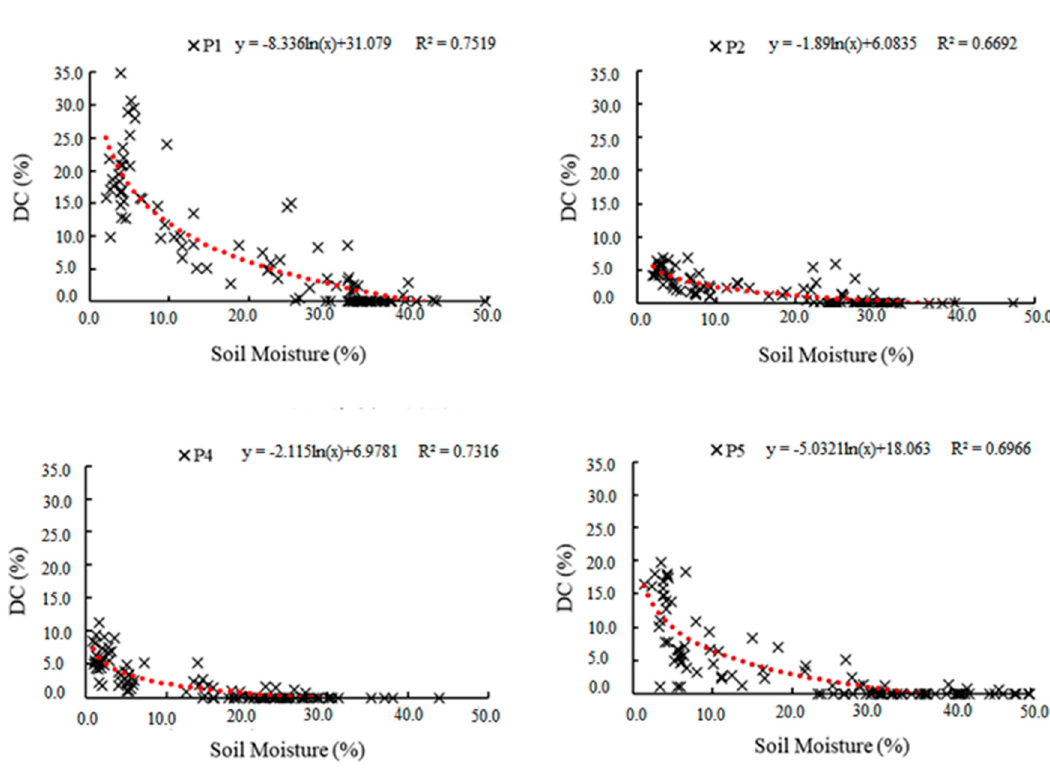
Figure 11. Soil moisture vs. Dc for the CL cluster plots P1, P2, P4 and P5.